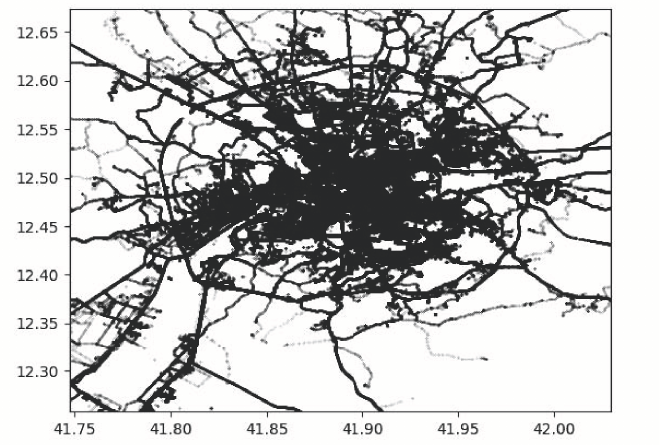
Figure 4. Taxi mobility traces in Rome [11].